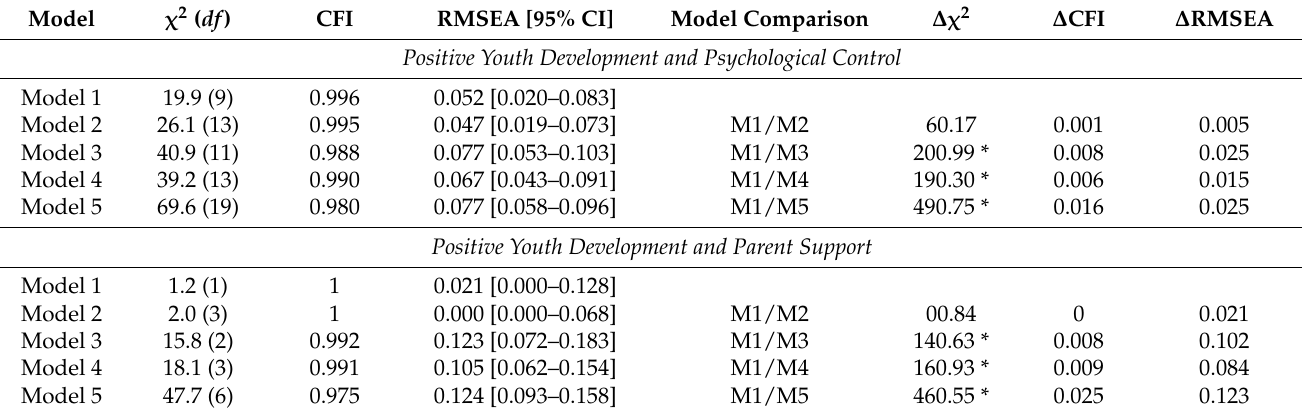
Table 2. Model fit of the random intercept cross-lagged panel models and model